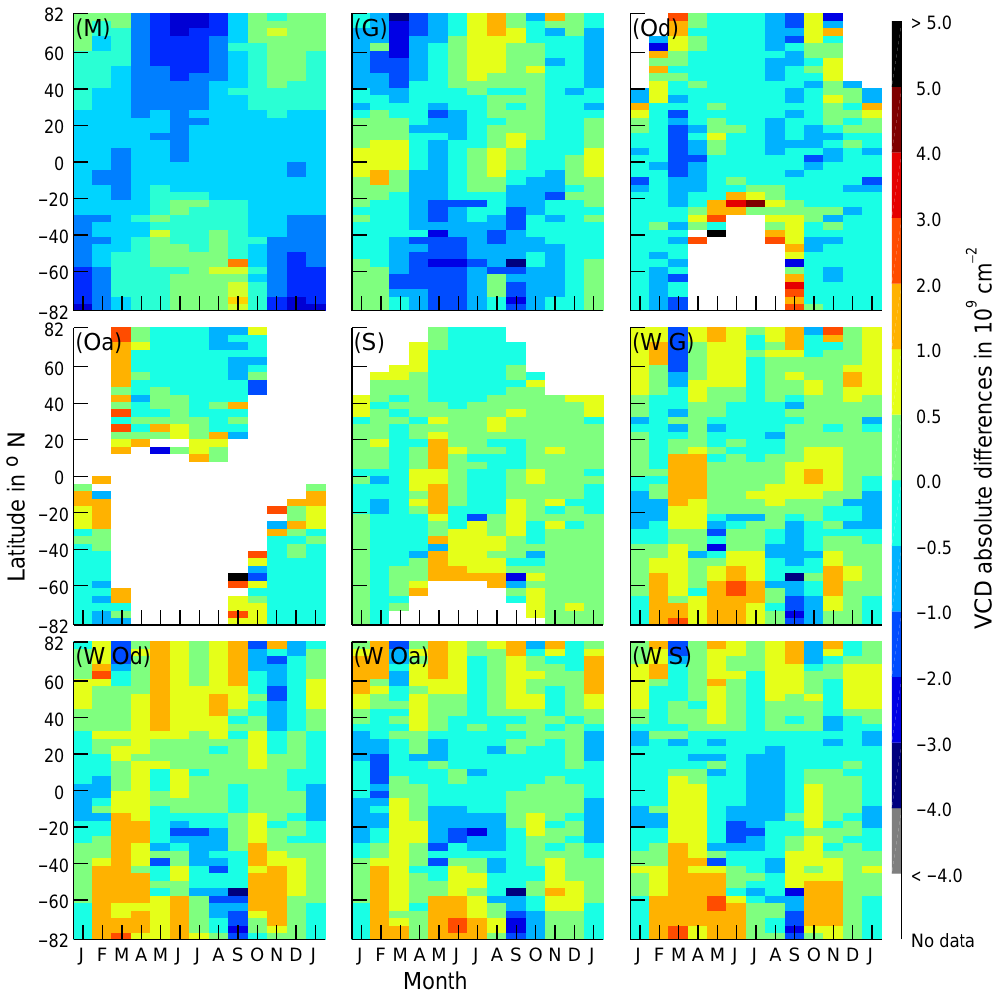
Figure 3. Absolute vertical column density differences of the individual instrument/model results compared to the ensemble mean. The panels are for the same results as in Fig. 2. The upper left panel shows the ensemble mean with the same color bar as in Fig.